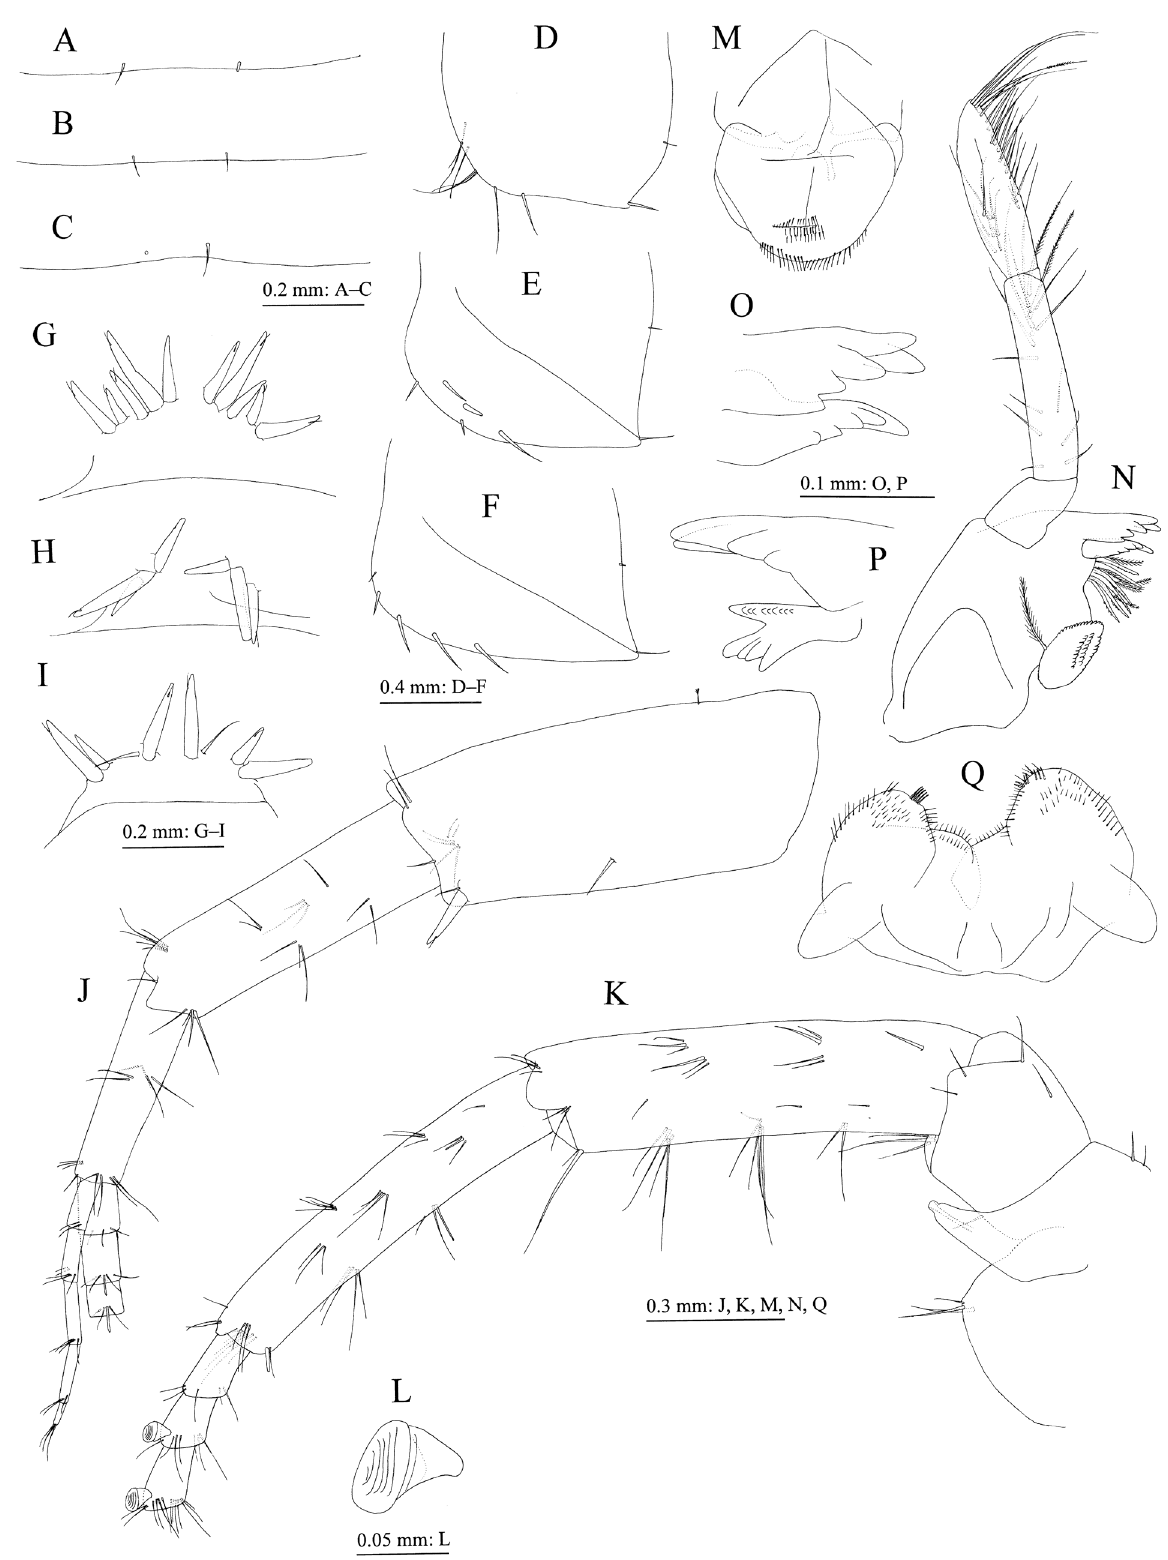
Figure 10. Jesogammarus uchiyamaryui sp. n., holotype, male (10.3 mm), NSMT-Cr 25474. A–C dorsal margins of pleonites 1–3, respectively, dorsal views; D–F epimeral plates 1–3, respectively, lateral views; G–I dorsal margins of urosomites 1–3, respectively, dorsal views; J peduncular articles 1–3, accessory flagellum, and flagellar articles 1–3 of antenna 1, medial view; K peduncular articles 1–5 and flagellar articles 1–3 of antenna 2, medial view; L calceolus of antenna 2, medial view; M upper lip, anterior view; N left mandible, medial view; O incisor and lacinia mobilis of left mandible, lateral view; P incisor and lacinia mobilis of right mandible, lateral view; Q lower lip, ventral